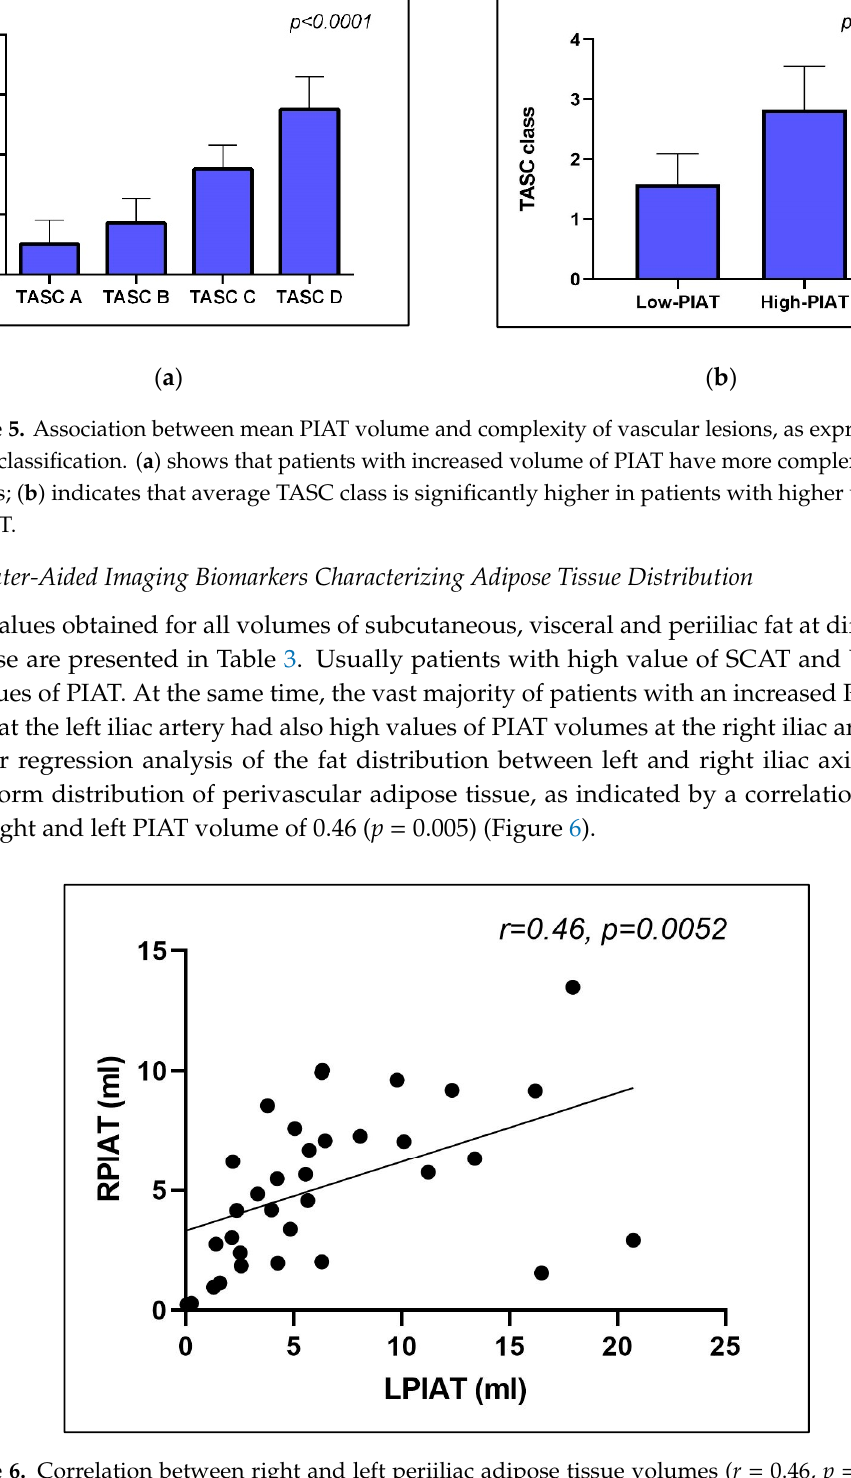
*RPIAT = right periiliac adipose tissue, LPIAT = left periiliac adipose tissue. RPIAT = right periiliac adipose tissue, LPIAT = left periiliac adipose